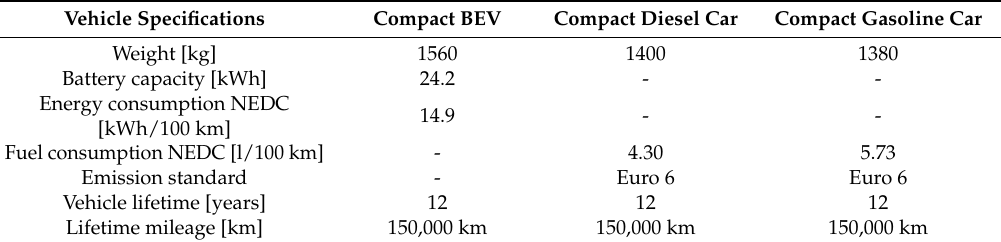
Table 1. Technical specifications of the compact BEV, diesel, and gasoline